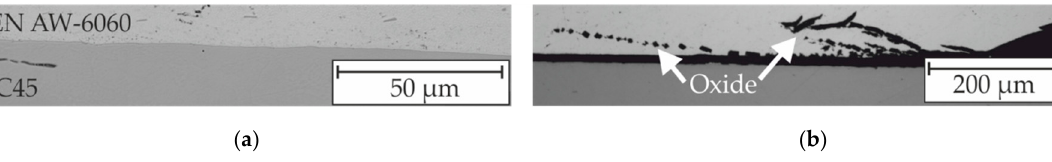
Figure 8. Polished cross section of the MPW sample joined with the Bmax setup (aluminum flyer